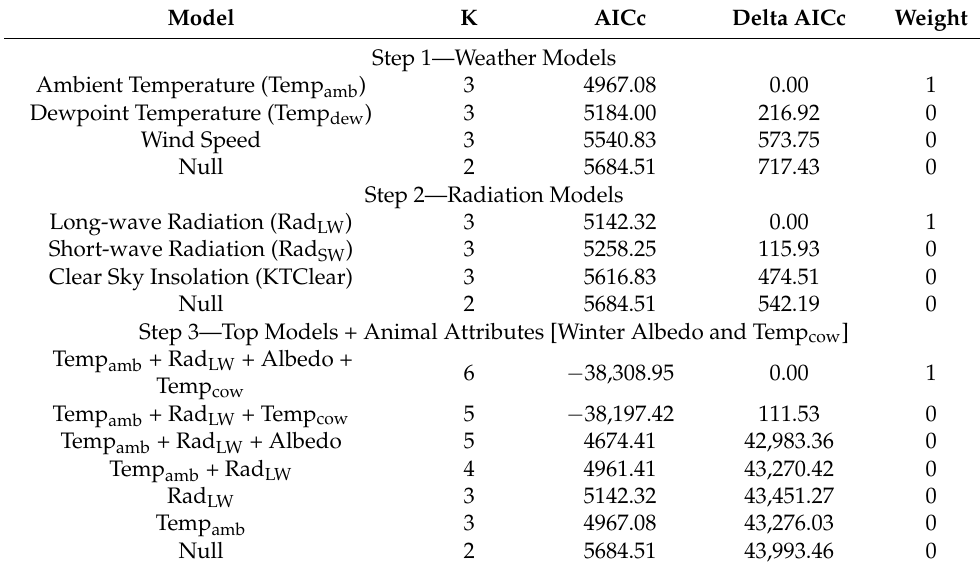
Table 5. Weather, radiation, and cow albedo models assessed for the difference ( ∆ T) between external surface temperatures of cattle (Temp cow ) and the ambient temperature of the surrounding environment (Temp amb ) for white, red, and black Bos taurus cows near Laramie, WY, USA.